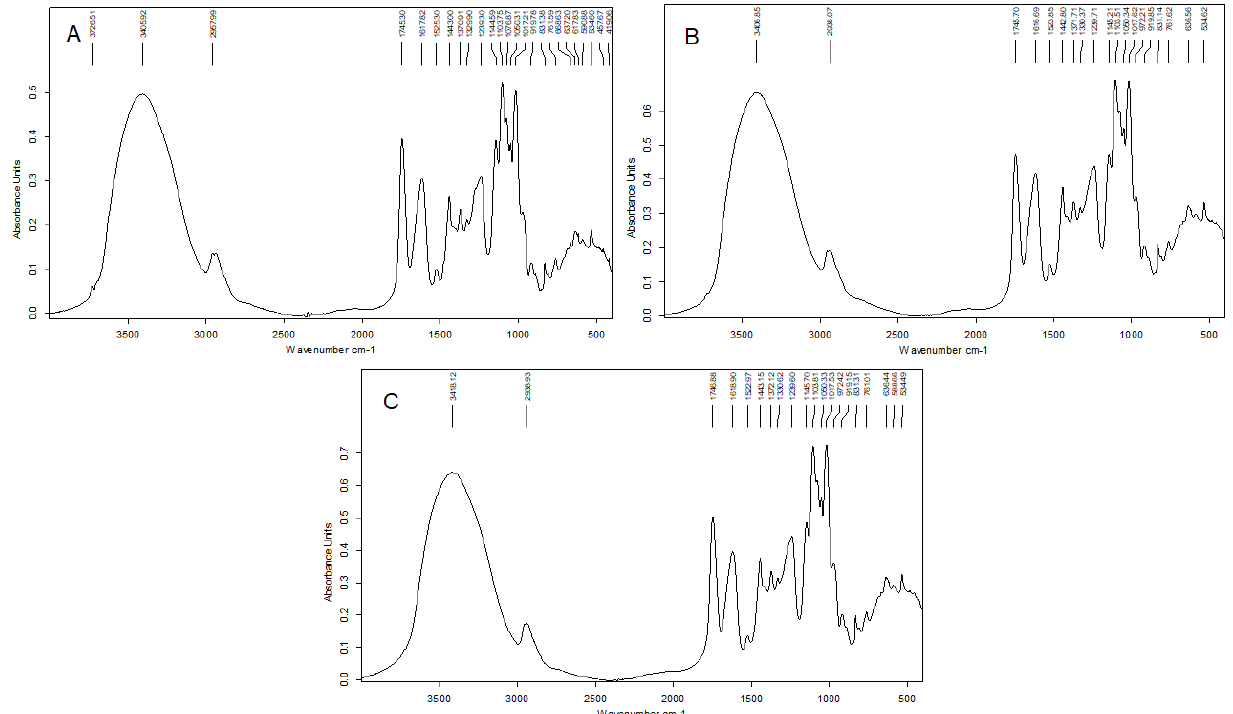
Figure 4. FT-IR spectra of the PSs isolated from non-irradiated ( A ), 10 kGy- ( B ), and 25 kGy-irradiated ( C ) RH fruits.